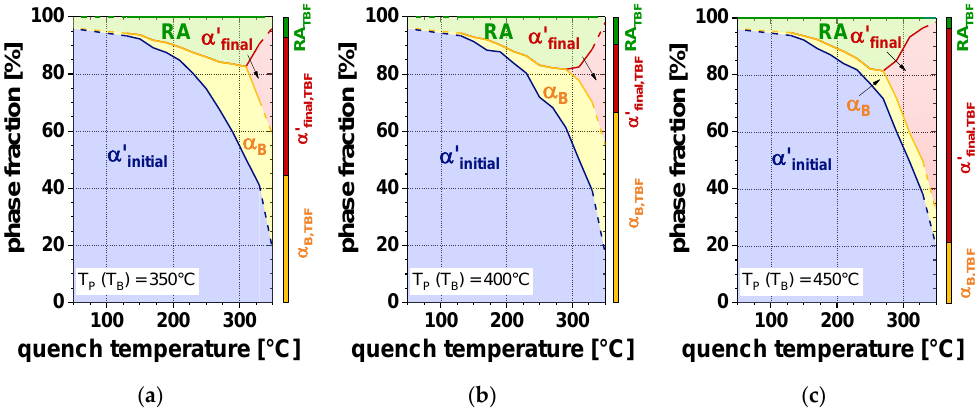
◦ C, ( b ) 400 ◦ C, and ( c ) 450 ◦ C. Q for a T P ( T B ) of ( a ) 350